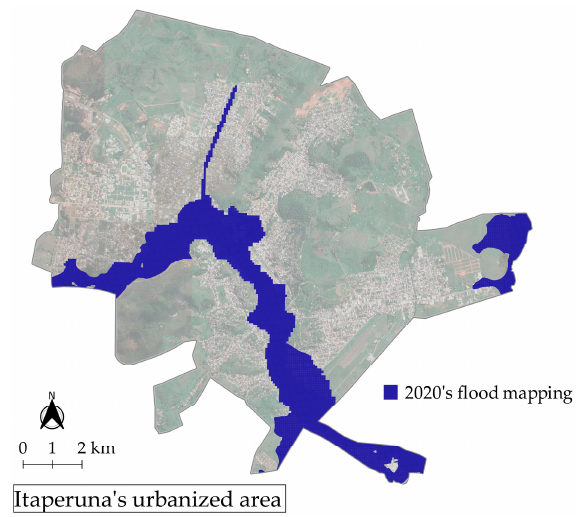
Figure 4. Flood occurrence mapping of Itaperuna considering the populated areas affected by the event of January 2020, elaborated by aerial images recorded by drones [ 45 ].